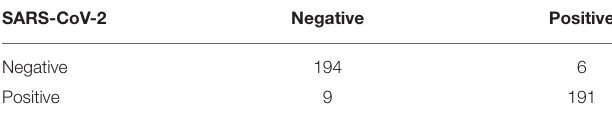
TABLE 4 | Confusion matrix of COVID-Net CXR-2 network.